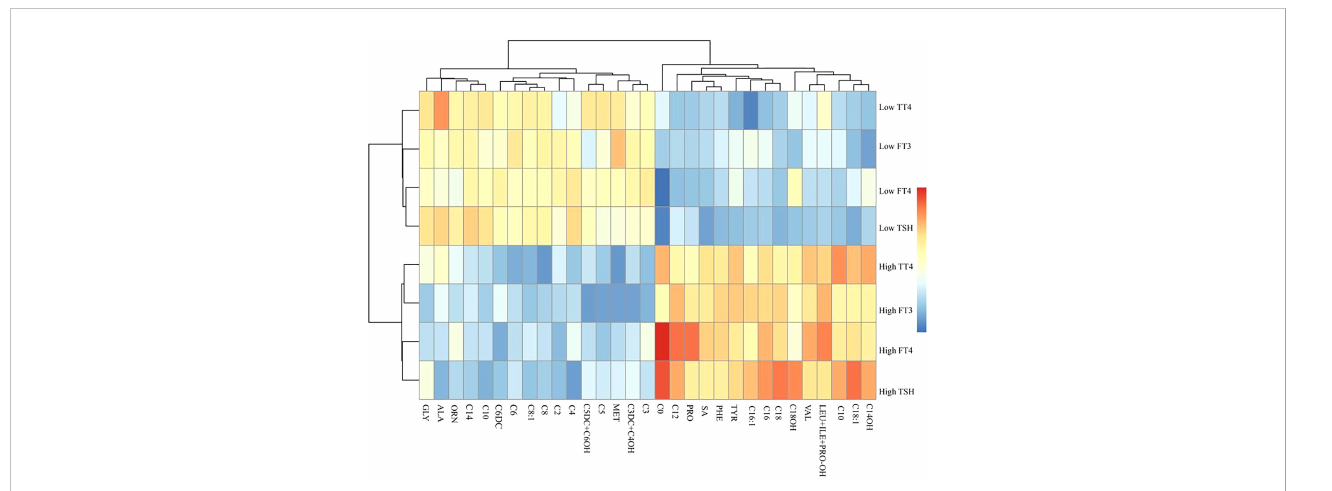
FIGURE 1 A clustering heatmap illustrating the classi fi cation between carnitine-related metabolites and thyroid hormones. Both the rows of thyroid hormones and the columns of carnitine-related metabolites have been clustered,